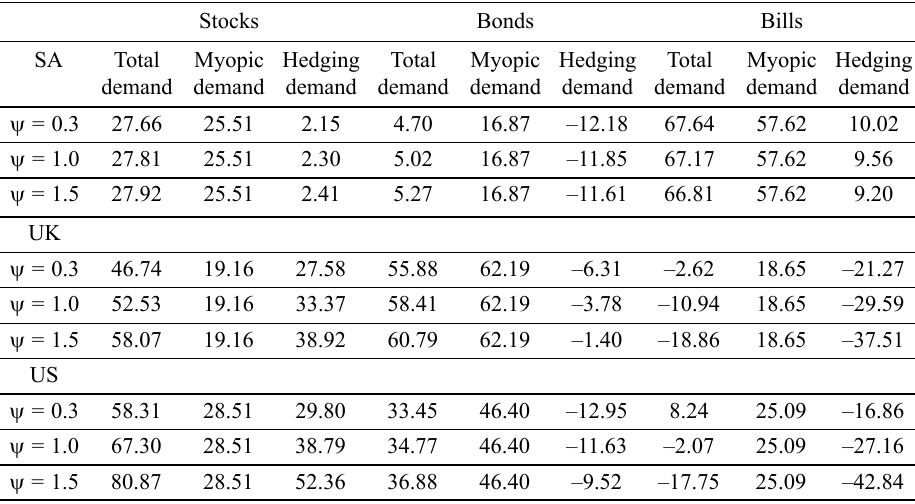
Table 3. Mean demands for domestic assets for investors in different countries assuming different y values with g = 7,